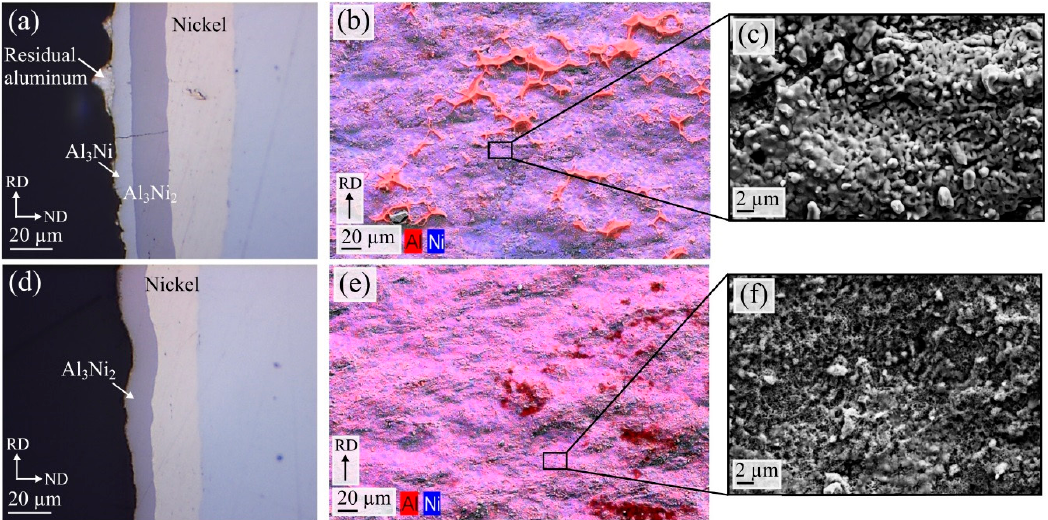
Figure 11. Comparisons of the fracture mechanisms observed in the composites after heat treatment at ( a )–( c ); 500 °C and ( d )–( f ); 550 °C. ( a ) and ( d ) shows the cross-sections of the fractured composite taken by optical microscopy, ( b ) and ( e ) shows the SEM images combined with EDS color mapping of the fracture surface corresponding to ( a ) and ( d ), where the detected aluminum is colored red and nickel colored blue. ( c ) and ( f ) show high magnification SEM images of the areas highlighted in ( b ) and ( e ).